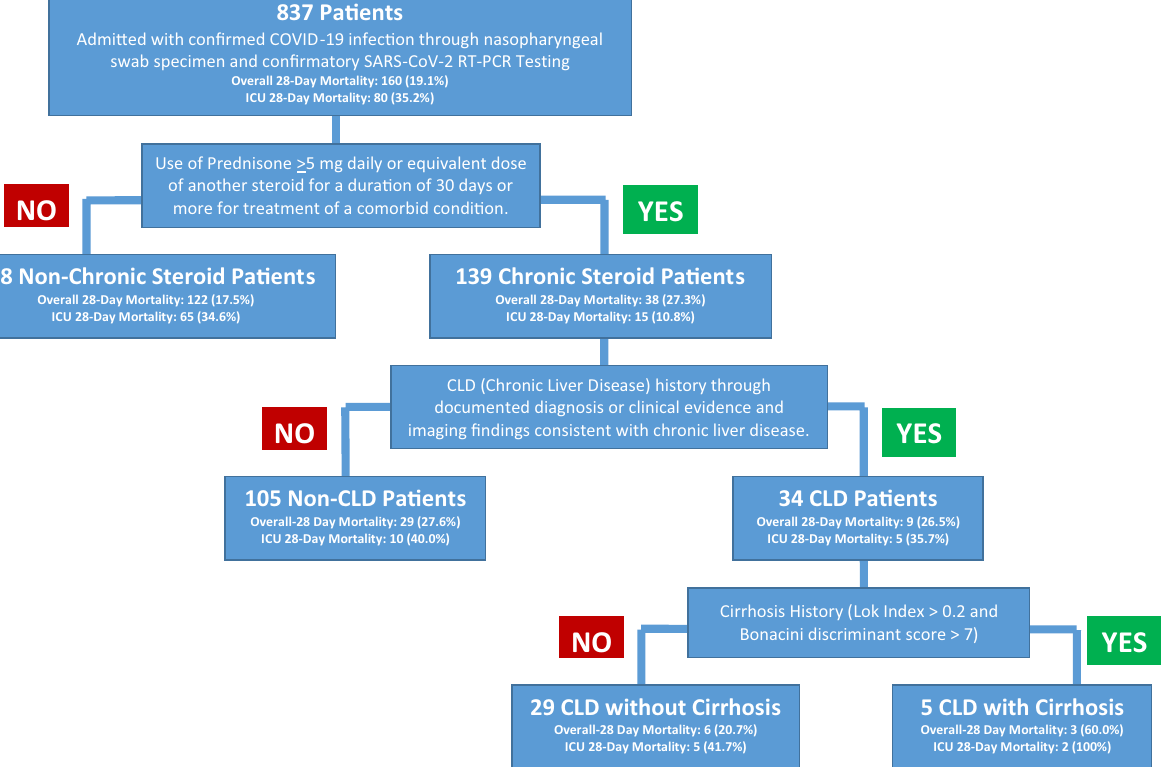
Figure 1. Step-wise approach utilized to obtain final patient sample of both CLD and non-CLD COVID-19 patients on chronic corticosteroids for comorbid